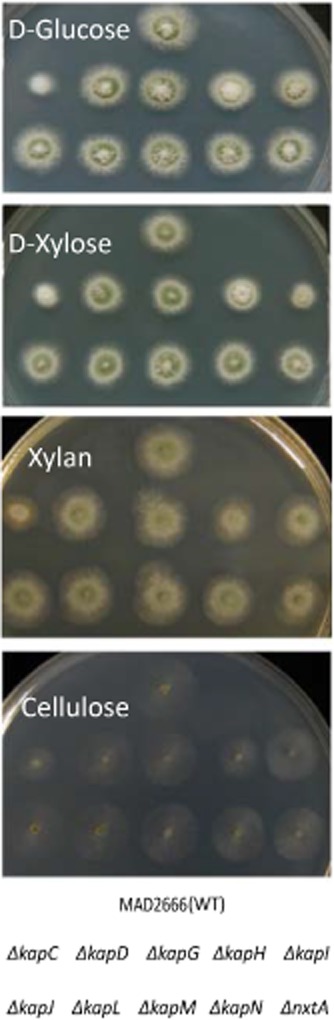
Growth of A. nidulans MAD2666 and mutant strains defective in selected kap genes (see Supporting Information Table S1) on D-glucose, the cellulose derivate CMC, xylan and D-xylose. Data from a single experiment are shown, but three replicates yielded consistent results. The order of strains and kap mutants for all carbon sources is shown in the sketch at the bottom of the figure.